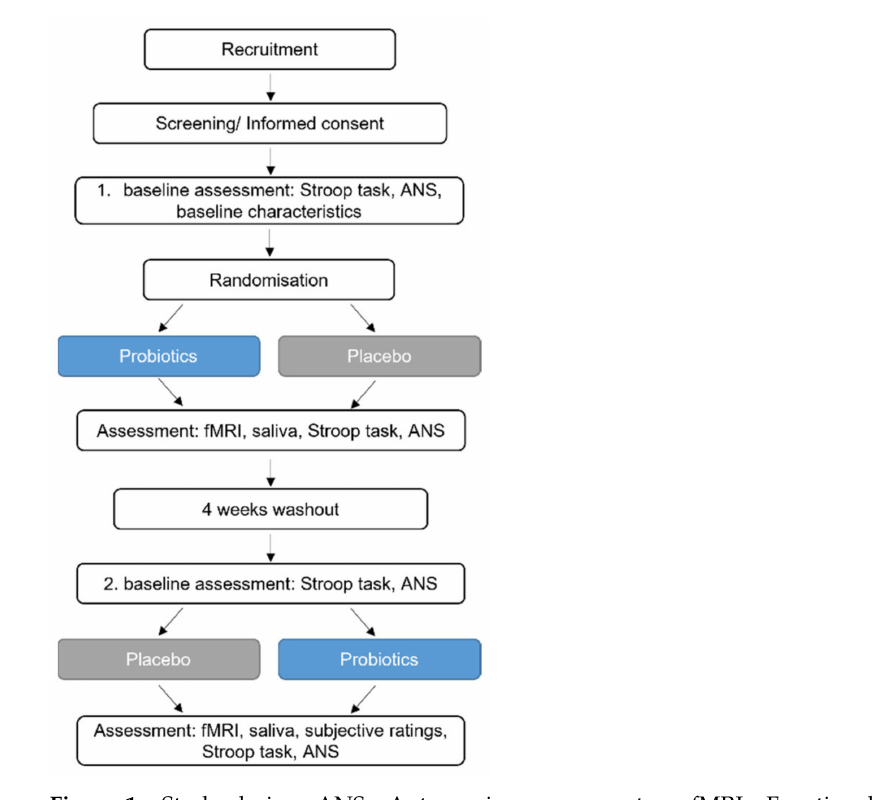
Figure 1. Study design; ANS—Autonomic nervous system, fMRI—Functional magnetic reso- nance